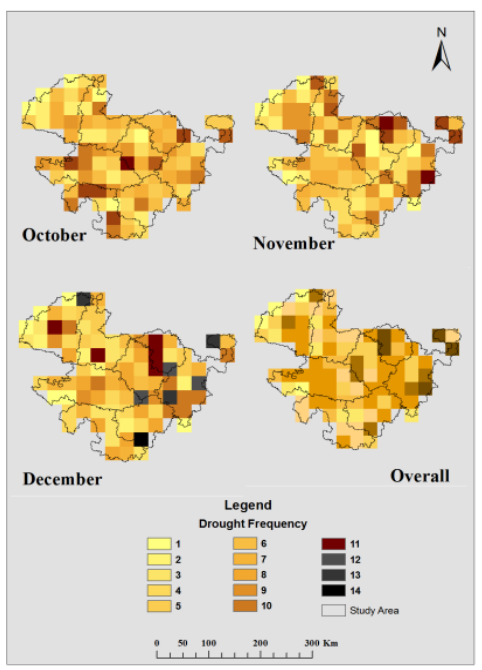
Figure 3. Spatio-temporal variations in VCI over the month of October Figure 4. Month-wise number of years under vegetation drought condition from